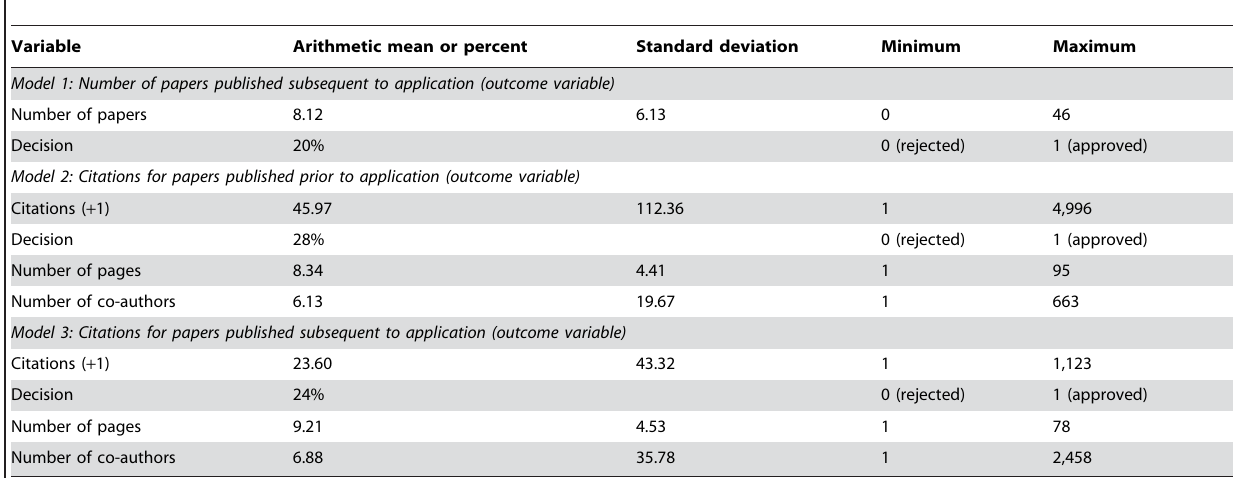
Table 1. Description of the factors that were potentially associated with quantity and impact of research publications (applicants for the LTF programme).